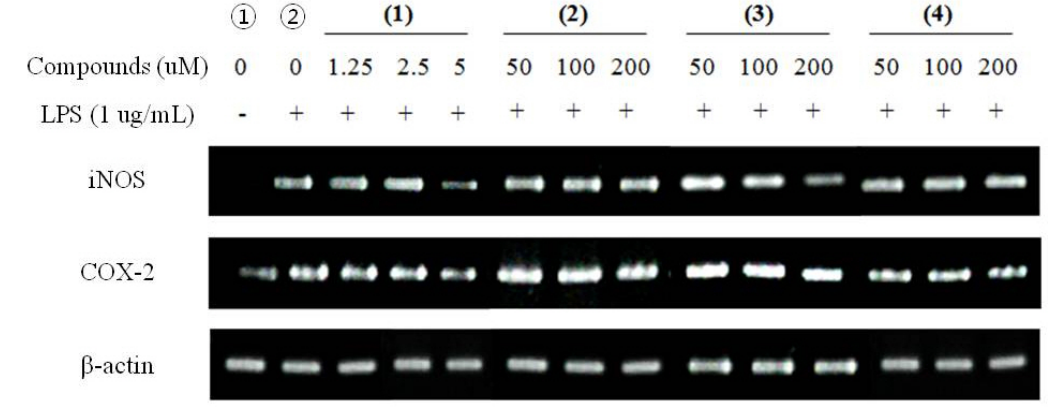
Figure 4. RT-PCR for anti-inflammatory effects with iNOS, and COX-2 mRNA expression in LPS-stimulated RAW 264.7 cells. The amount of RNA loaded in each lane was confirmed by β -actin mRNA. ( 1 ) Falcarindiol; ( 2 ) ( Z